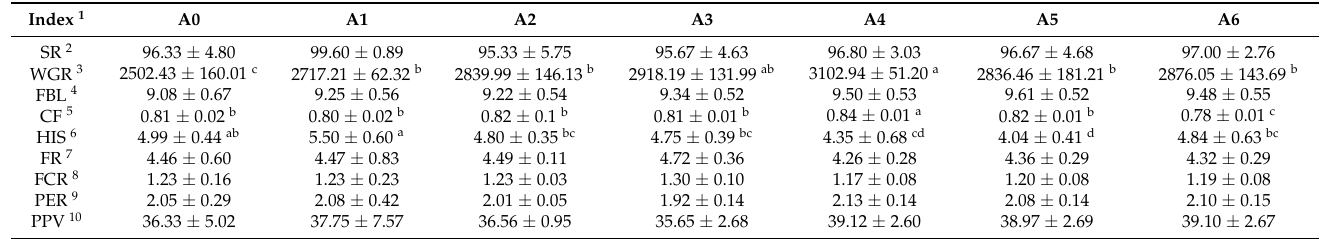
Table 2. Effects of Yarrowia lipolytica on growth performance and feed utilization of Litopenaeus vannamei 1